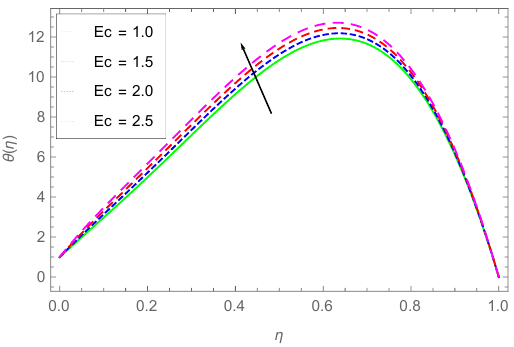
Figure 12. θ ( η ) dependence on Ec .